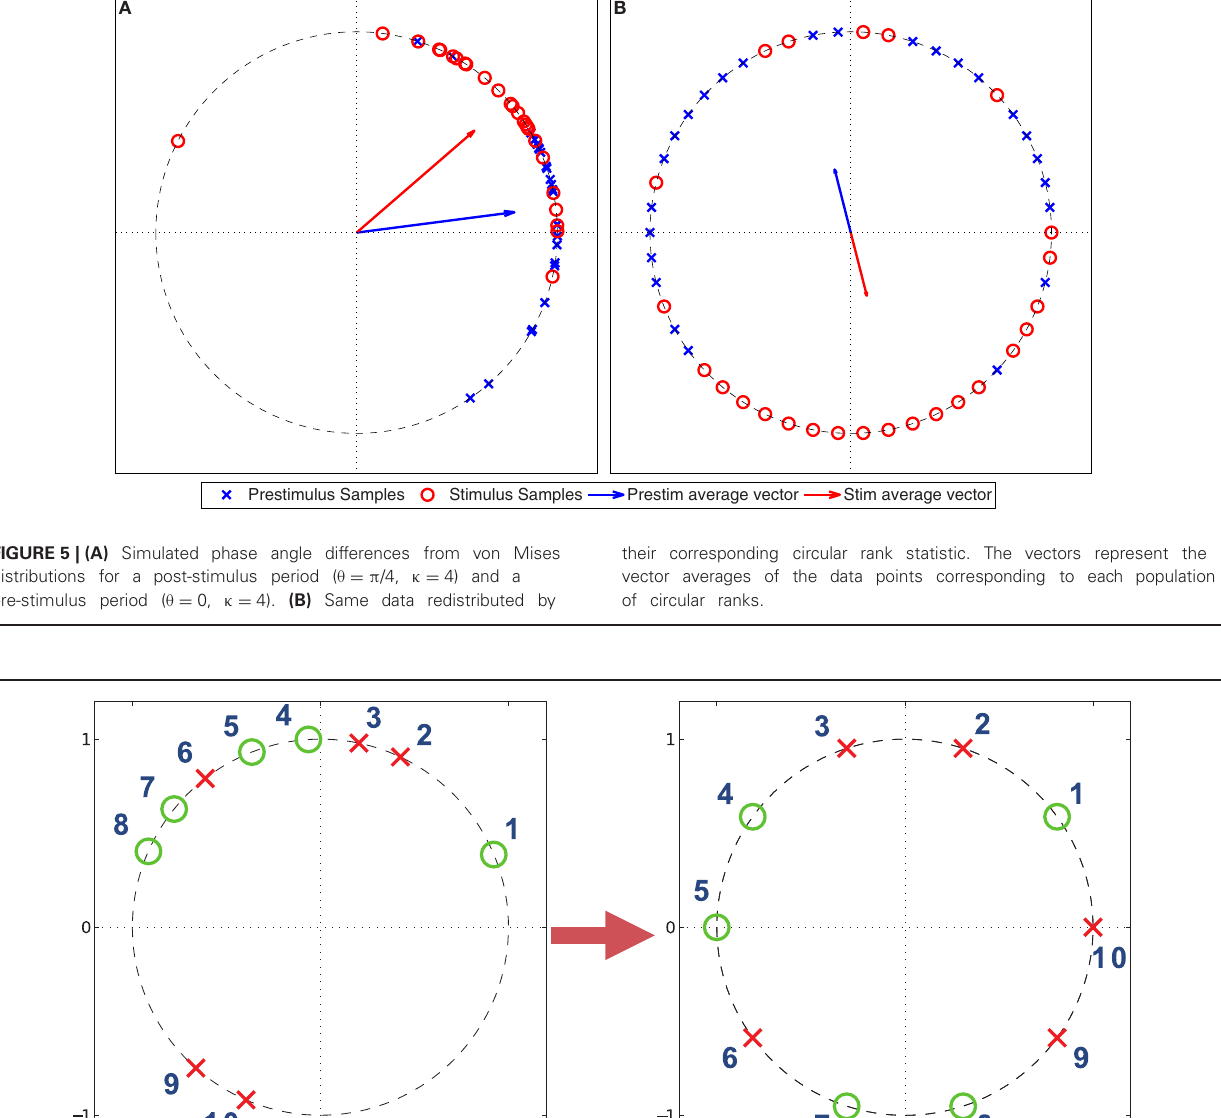
of the points. The repositioned points are equally spaced around the unit circle and the order of the classification of the red and green points is